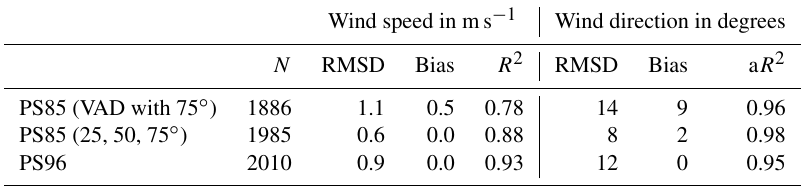
Table 4. Statistics for lidar data (at approx. 50–75m) compared to the ship anemometer (at 39m). N indicates the number of comparisons (for the wind direction, one case with wind speed < 0.5ms − 1 was removed). aR is the correlation coefficient for angular